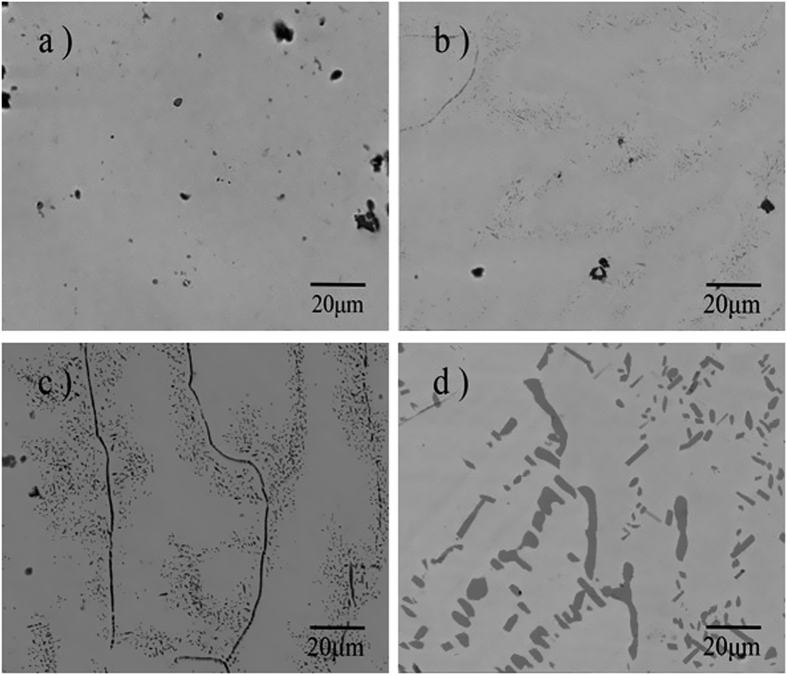
Backscattered electron images of Ni50−xFexMn39Sn11 alloys (a) x = 0; (b) x = 3; (c) x = 4; (d) x = 6.